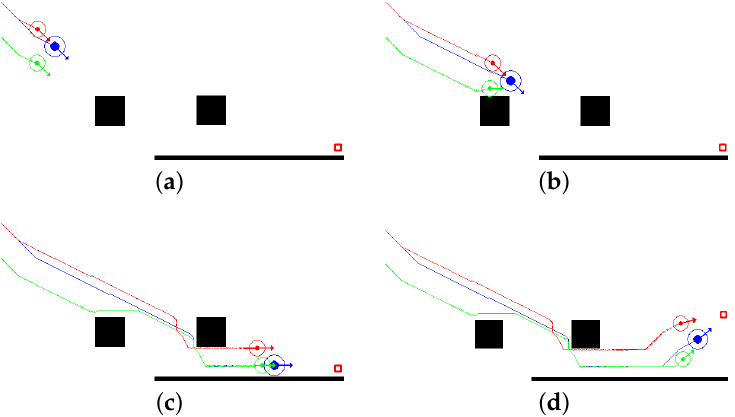
Figure 5. Simulation results at different time intervals, showing the behavior of the agents while going through obstacles. ( a ) Mission start with agents in formation, with leader in blue, agent 2 in red, and agent 3 in green. ( b ) Obstacle in range, agent 3 deviates by performing necessary calculations. ( c ) Traces of movement while going through the obstacles. ( d ) Agent 3 comes back to its intended position in the formation when there is no